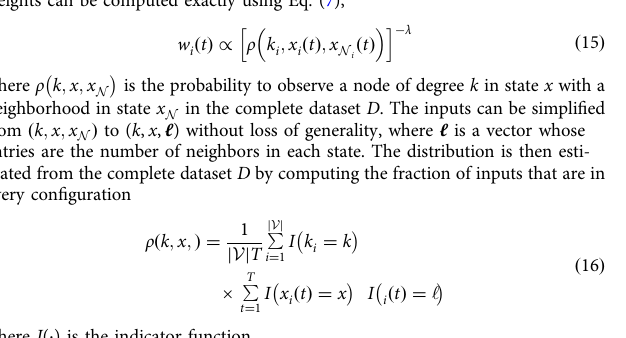
. For the simple, i ¼ 1 :: N